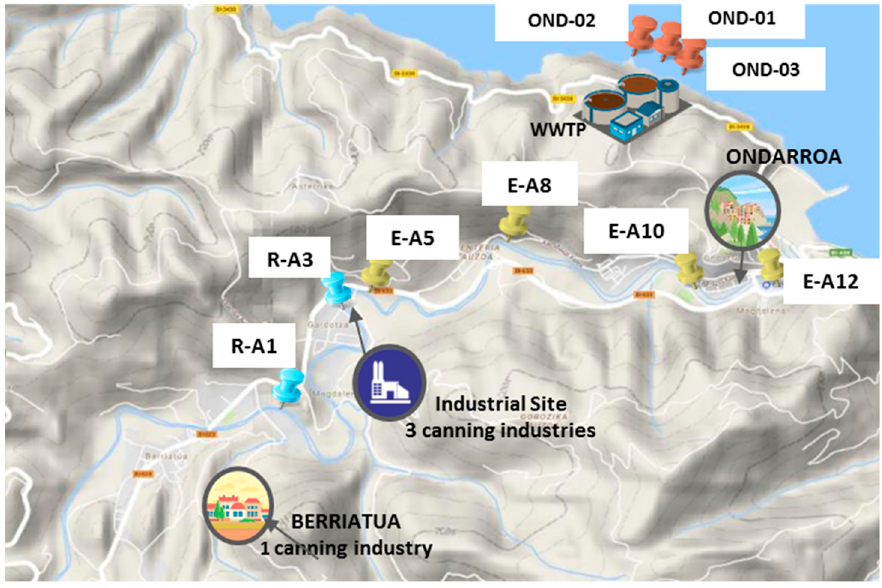
Figure 4. Sampling stations for the measurement of different variables in surface water. Table 2. Location of sampling stations.